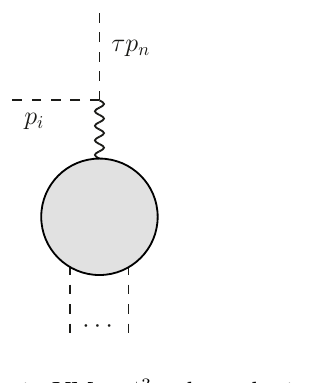
Figure 11 . The additional pole diagram in YM + φ 3 , where the internal line that gives the 1 /τ pole is a gauge